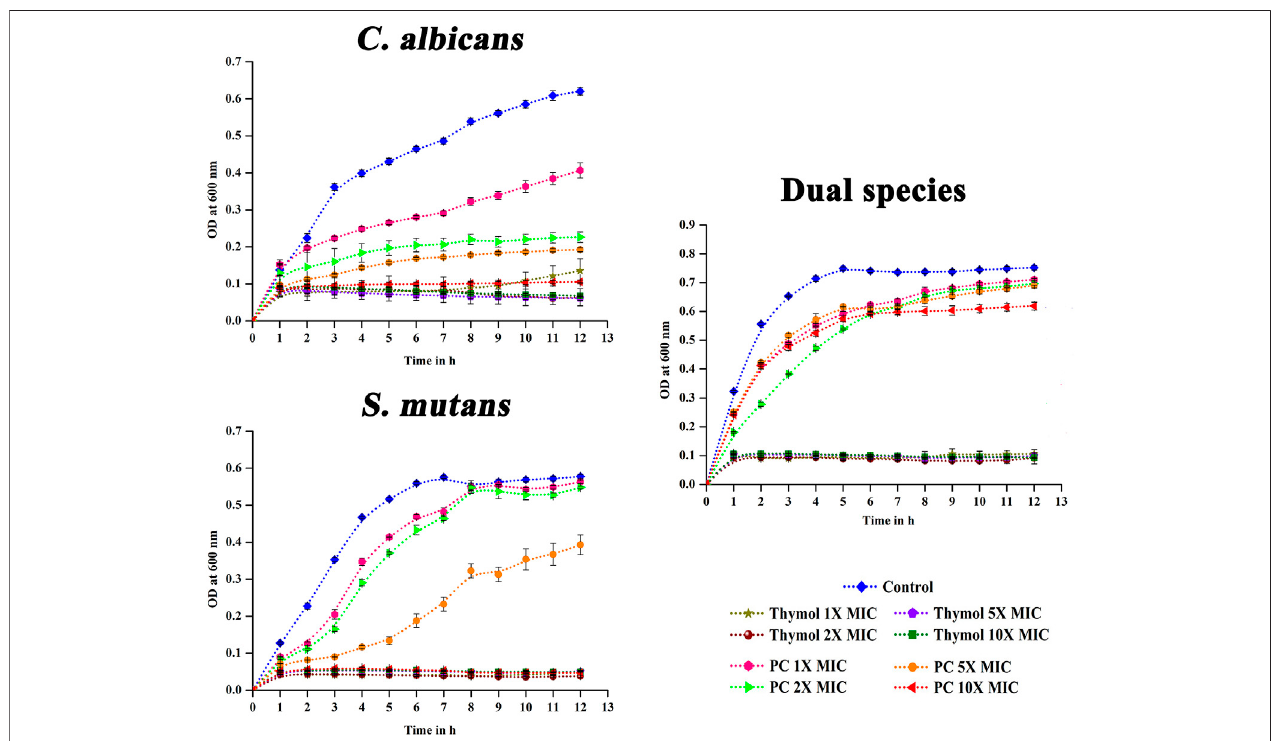
FIGURE 5 | Post antimicrobial effect of thymol. Brief exposure to 1X – 10X MIC of thymol signi fi cantly suppressed the proliferation of the pathogens in single as well asdualstate,whereaspositivecontrolsdidnotexhibitsigni fi cantpostantimicrobialeffect.PC,positivecontrol.AmphotericinB(MIC-2.5 μ g/ml)andchlorhexidine(MIC- 16 μ g/ml) were used as the positive control for C. albicans and S. mutans , respectively. For dual species, amphotericin B and chlorhexidine were used in combination. Error bars represent standard deviations from the